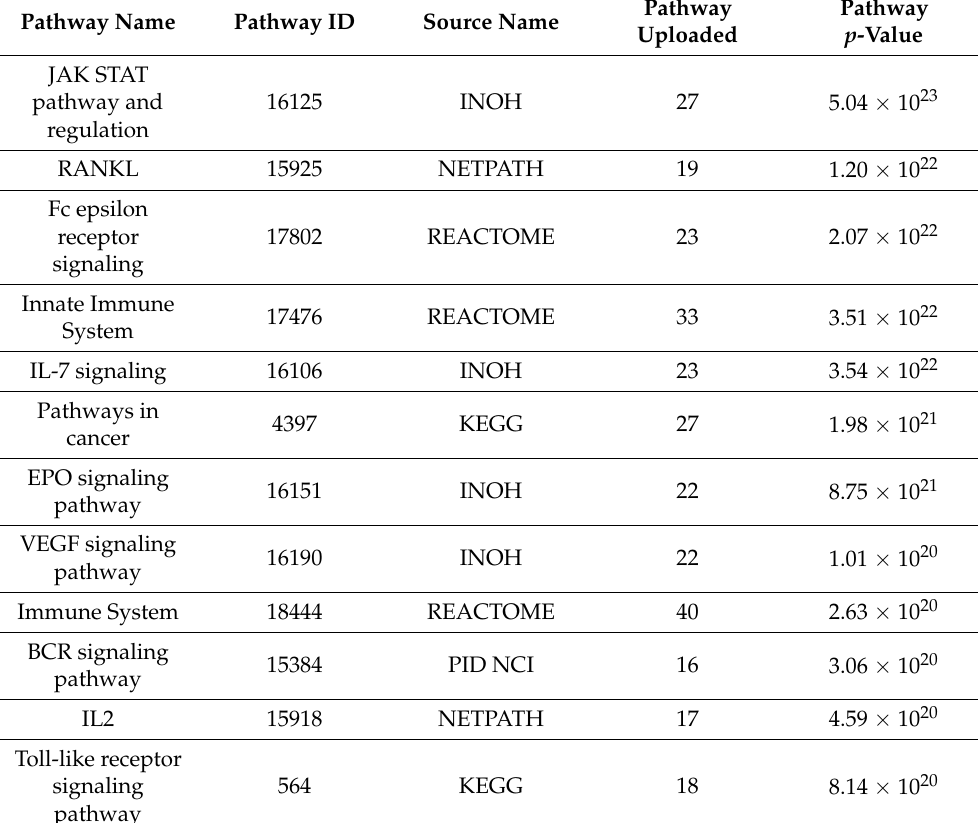
Table 3. Pathway Over-Representation Analysis PCEP Site of